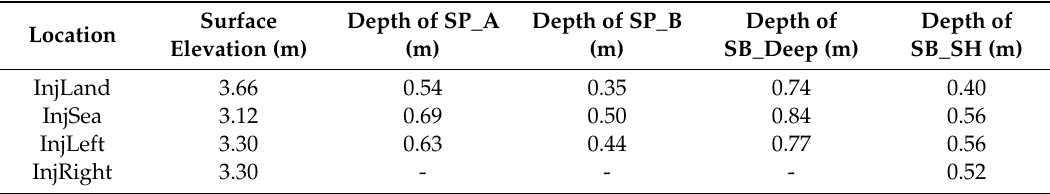
Table 1. Surface elevations and depths of sampling boxes (SBs) and sampling ports (SPs) from the surface for the corresponding well locations.